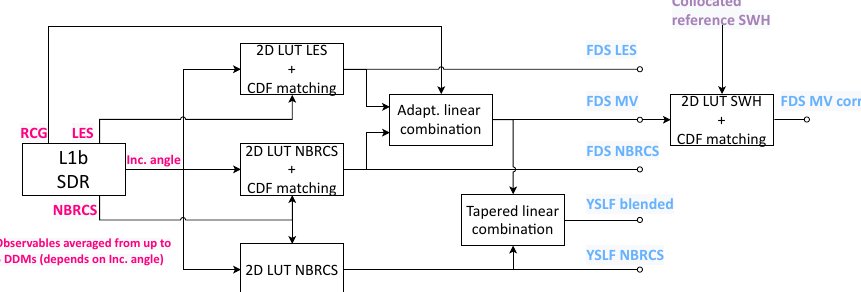
Figure 1. Generation of the different SOC L2 SDR wind speed retrievals and of the SWH LUT correction presented